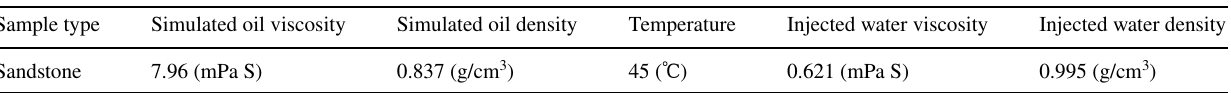
Table 1 Experimental conditions for oil–water relative permeability test Sample